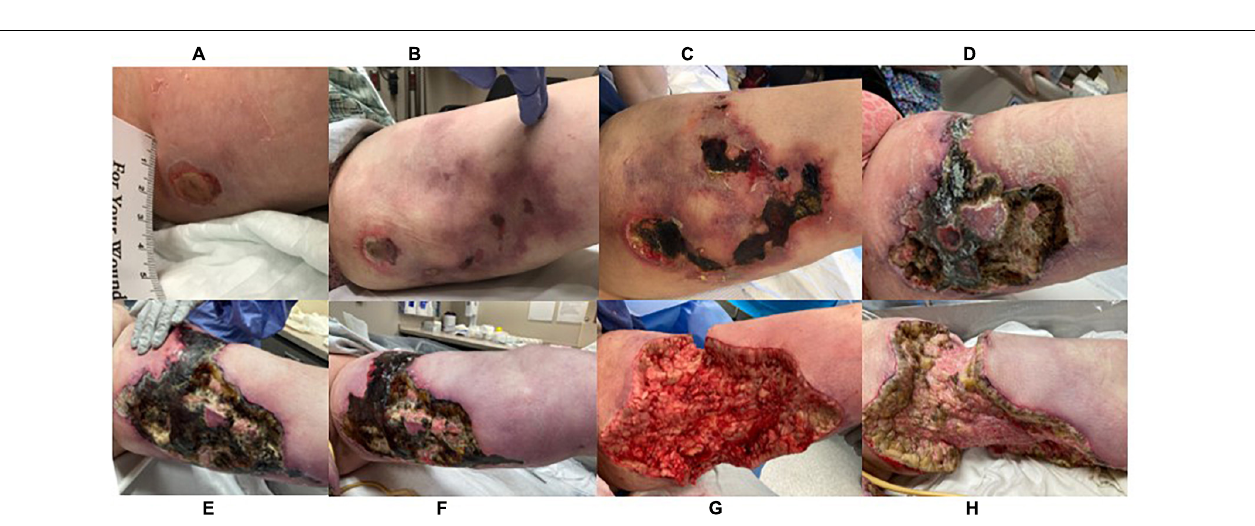
FIGURE 2 | Lesion progression of left medial thigh over 3.5 months. (A) 8/27/21 , (B) 9/11/21, (C) 9/27/21, (D) 10/26/21, (E) 11/16/21, (F) 11/30/21, (G) 12/1/21, taken immediately post debridement in operating room (H)